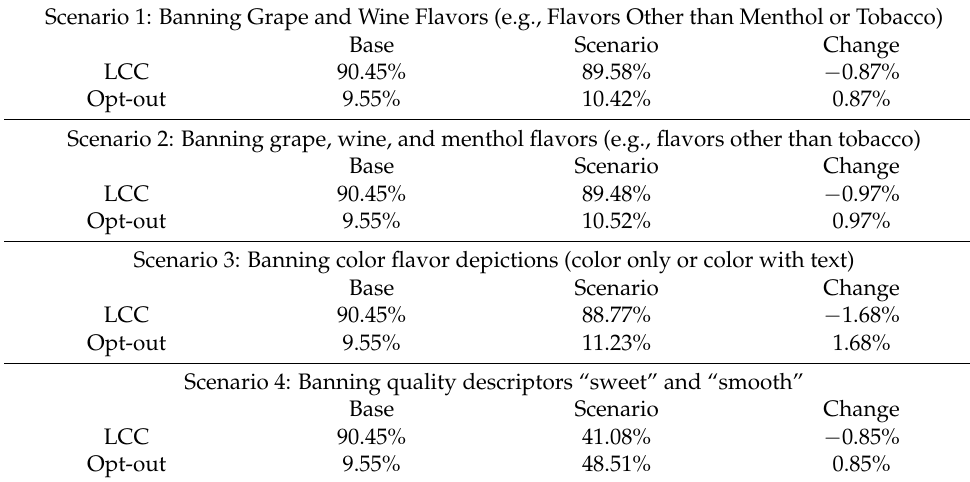
Table 3. Policy impact simulation of potential LCC packaging